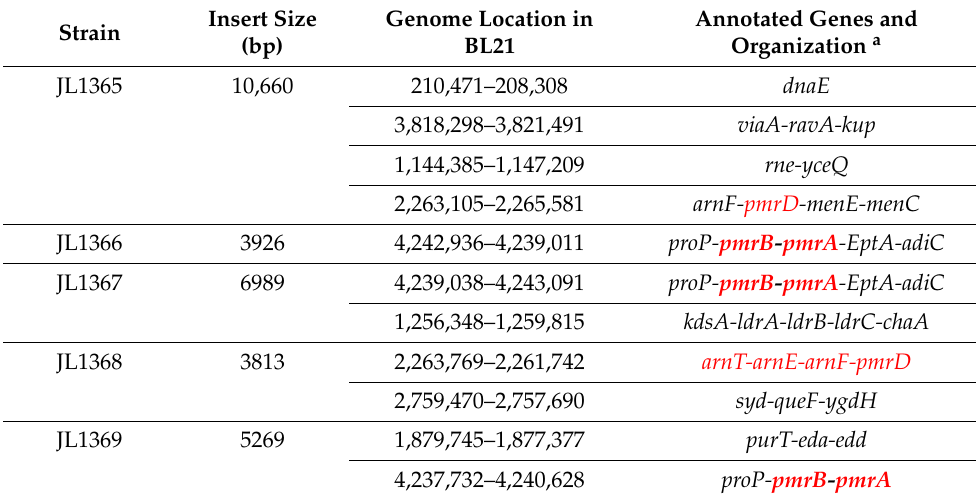
Table 3. Functional cloning of colistin resistance determinants from E. coli BL21(DE3). Insert Strain